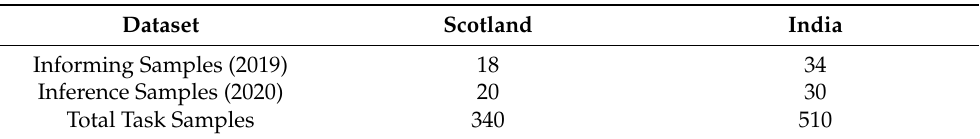
Table 1. Resulting sample counts for each dataset. The bottom row contains the total count for 17 cloud masks.